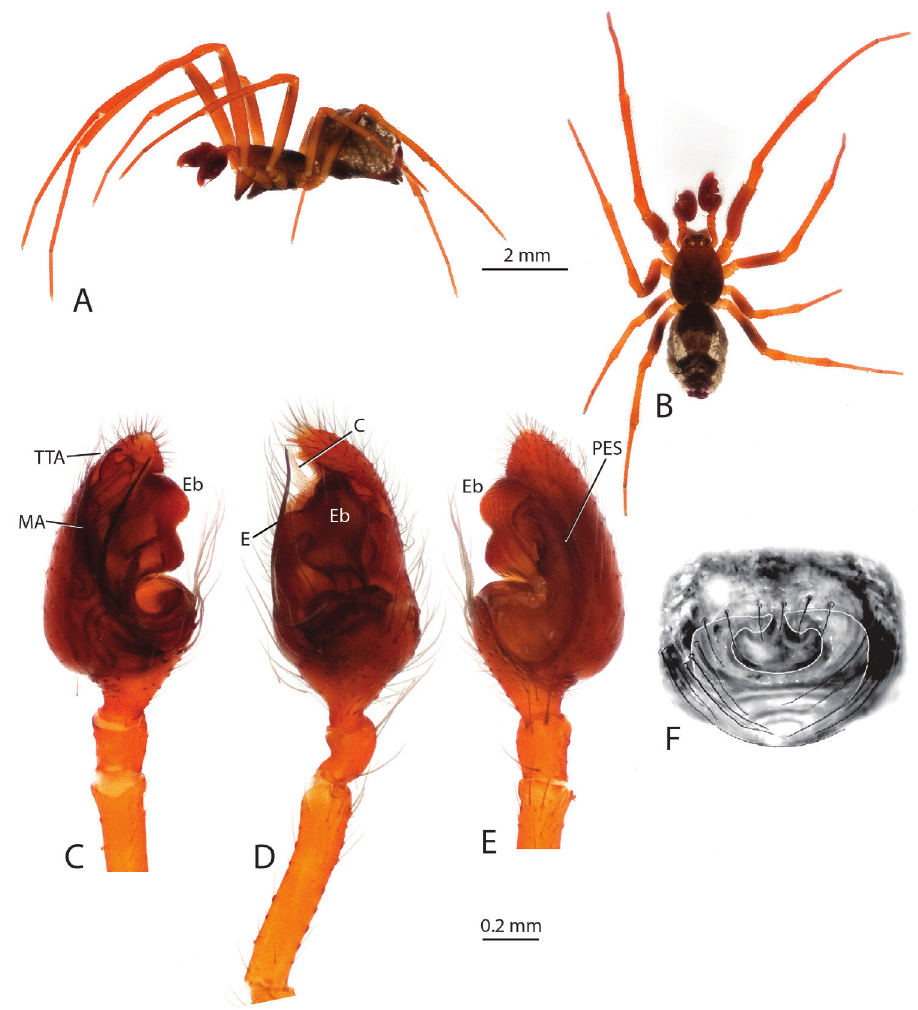
Figure 4. Anelosimus salut : A–B male lateral and dorsal views C–E male palp mesal, ectal, ventral F epigynum,